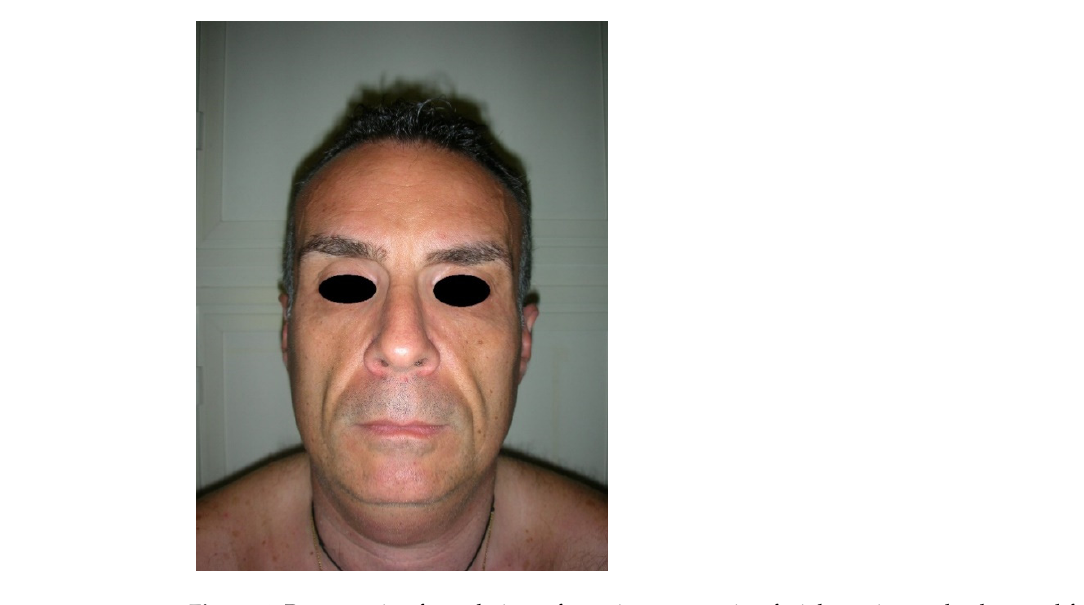
Figure 4. Preoperative frontal view of a patient presenting facial wasting and submental fullness.